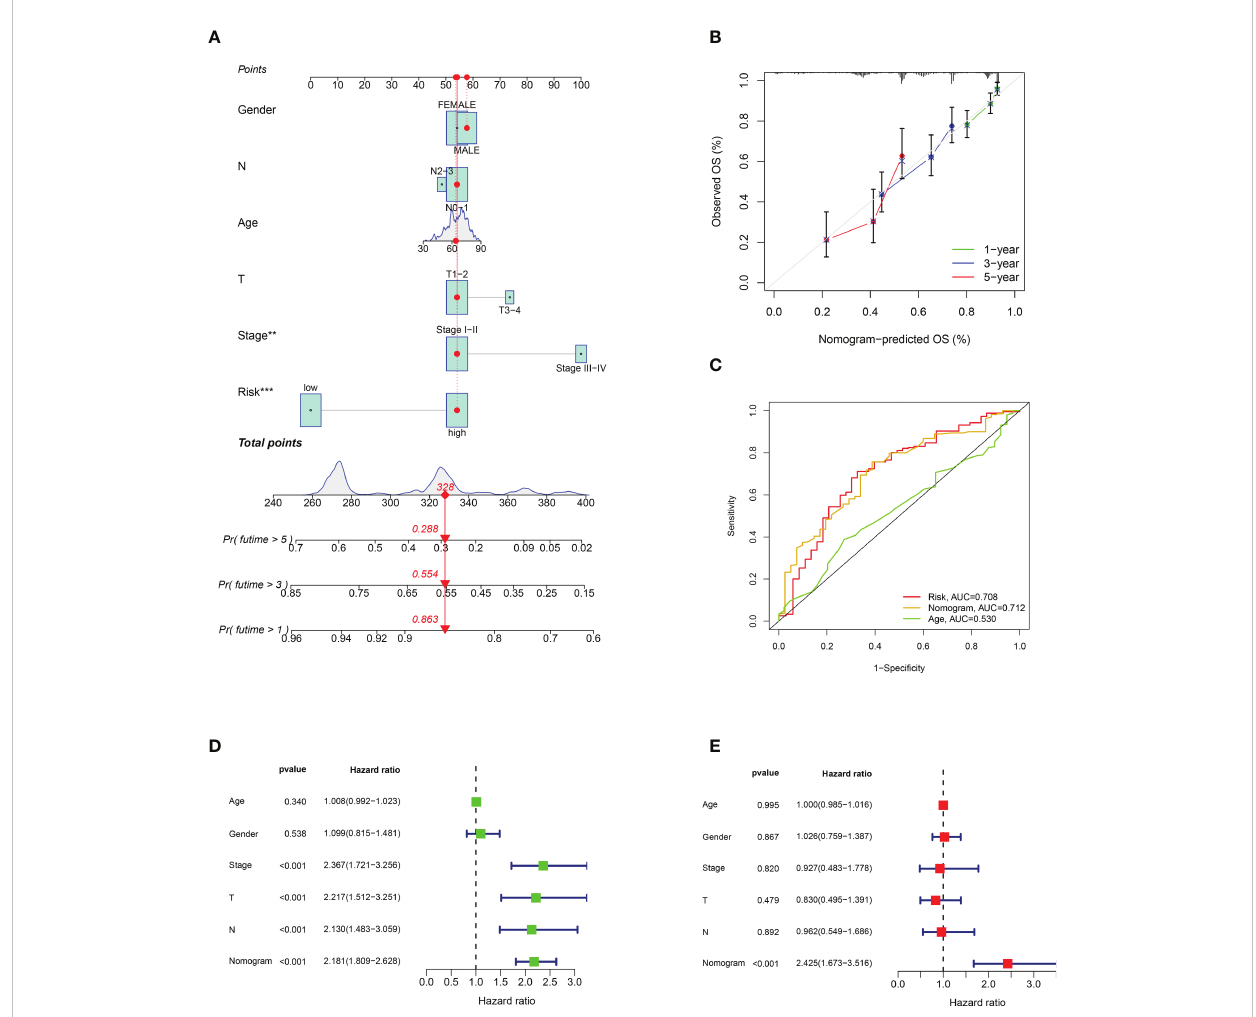
FIGURE 5 Establishment and veri fi cation of nomogram. (A) Nomogram with risk score model and clinicopathological features. (B) Calibration diagram of the nomogram. (C) TCGA-LUAD risk score and clinical characteristics ROC curve. (D, E) Univariate and multivariate Cox regression analyses of the nomogram. **p < 0.001; ***p <